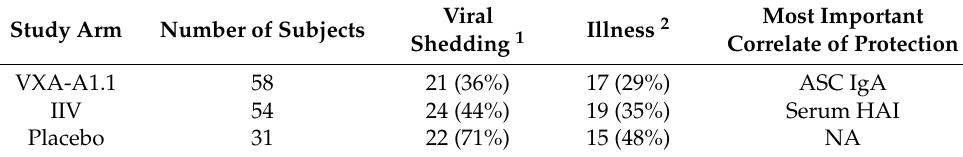
Table 2. Vaccine efficacy following H1N1